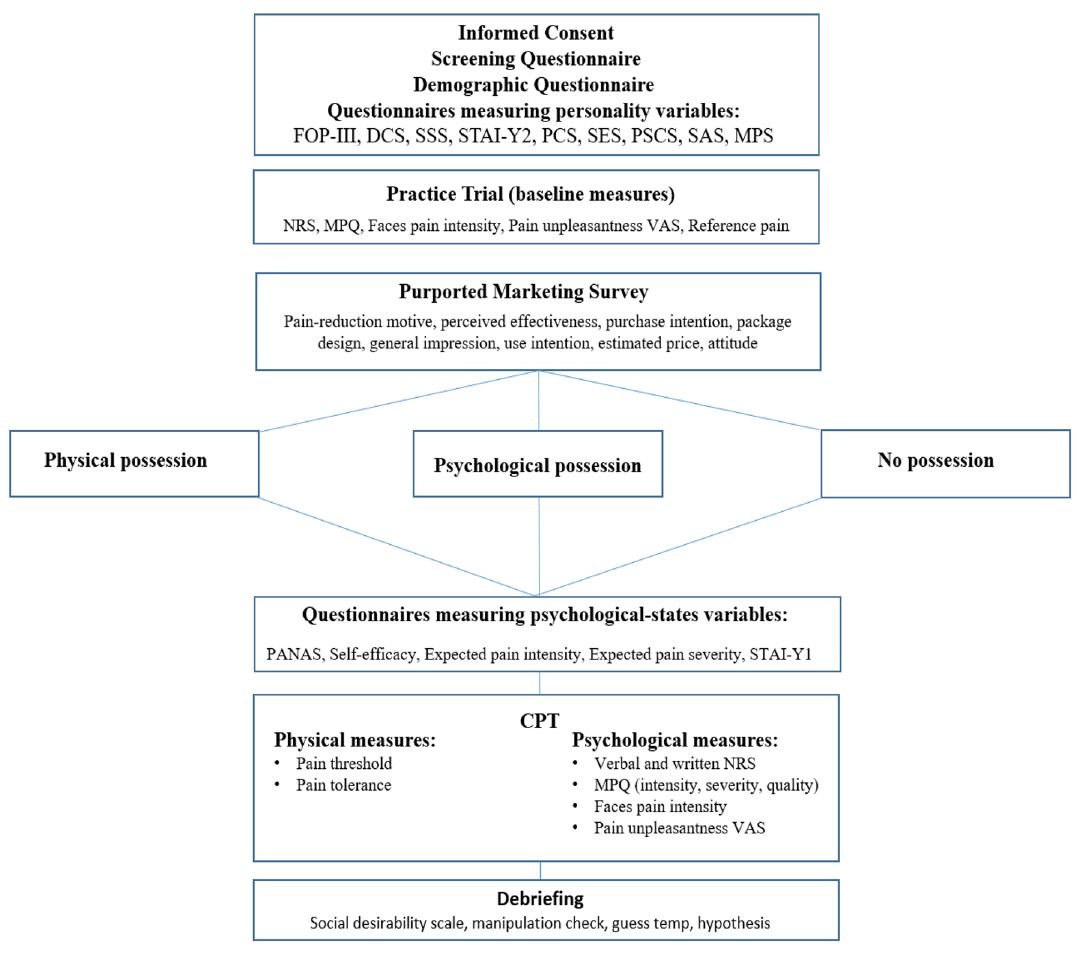
Figure 1. Flowchart of the experimental